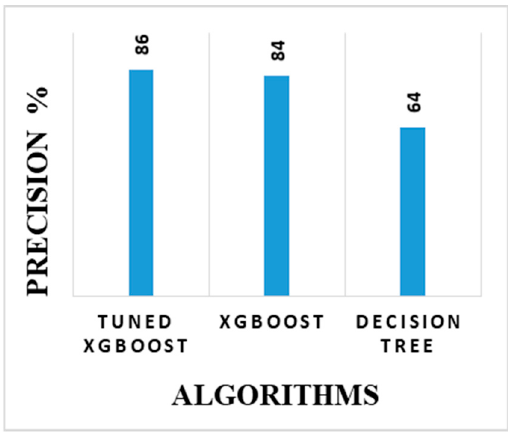
Figure 2. Comparison of precision.